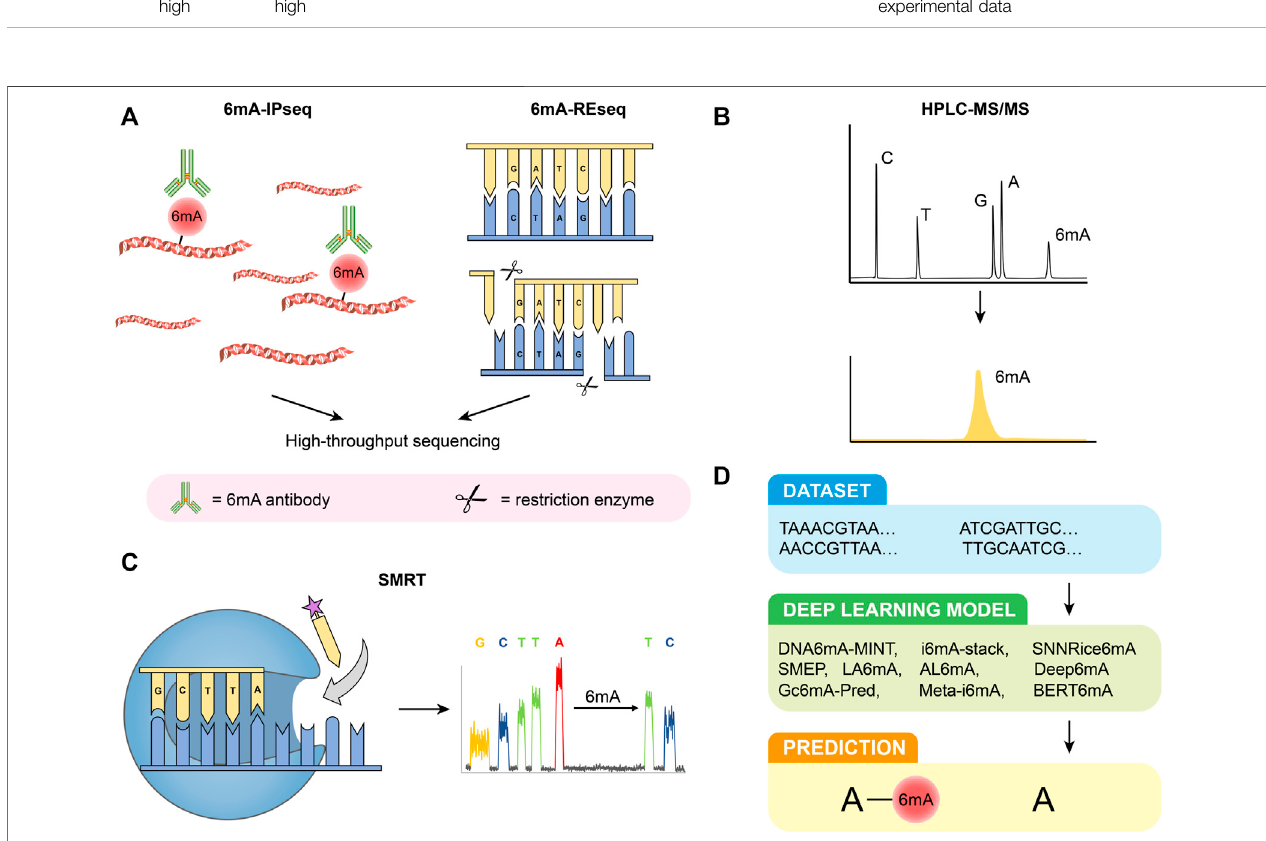
FIGURE 1 | Detection methods of 6 mA. (A) 6 mA-IPseq and 6 mA-REseq. (B) HPLC-MS/MS. (C) SMRT. (D) Deep learning predictive model.